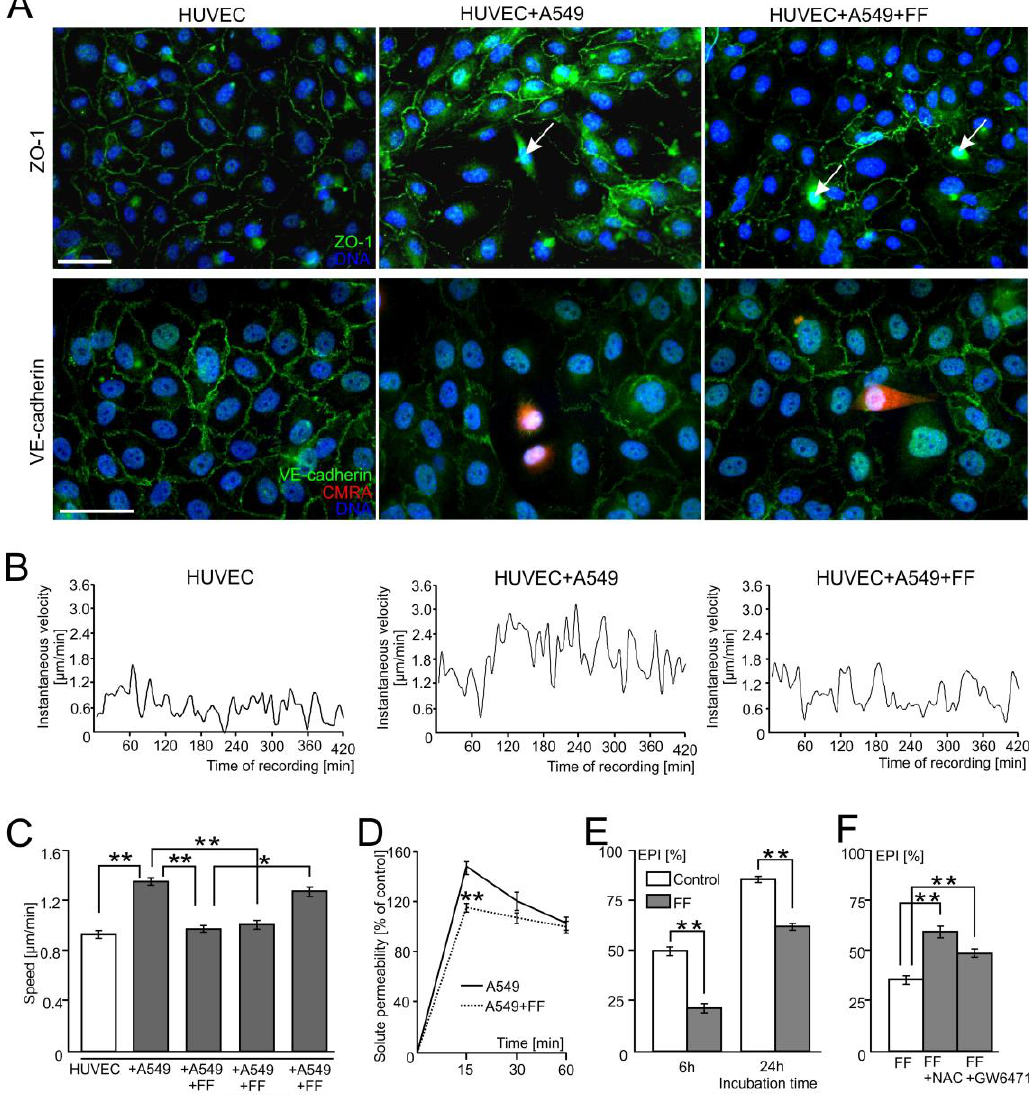
Figure 1. Fenofibrate inhibits the penetration of the endothelial layer by lung adenocarcinoma (A549) cells. Human lung cancer A549 cells (stained with CMRA-Cell Tracker or marked with arrows) were seeded onto human umbilical vein endothelial cell (HUVEC) monolayers at the density of 1300 cells/cm 2 . The integrity of endothelial continua, HUVEC motility, and endothelial permeability was assessed by anti-ZO-1/VE-cadherin immunostaining (( A ); 6 h), time-lapse videomicroscopy (( B , C ); 7 h), and solute permeability tests ( D ), respectively, in the absence or in the presence of 25 µ M fenofibrate (FF). ( B , C ) shows instantaneous speeds of single HUVEC in control conditions and in the presence of A549/25 µ M FF, and the comparison of average speeds of HUVEC movement in the presence of A549 cells/FF/GW6471/NAC, respectively, quantified based on changes in cell centroid position. ( E ) The effect of FF on the efficiency of A549 diapedesis (TransEndothelial Penetration; EPI) was estimated after 6 and 24 h of co-culture. ( F ) Effect of PPAR α inhibitor (GW6471) and ROS scavenger (N-acetyl-L-cysteine; NAC) on A549 diapedesis (EPI), estimated after 6 h of A549/HUVEC co-culture. Transmigration of at least 200 A549 cells was analyzed for each group. The statistical significance of the differences in ( C – F ) was tested with one-way ANOVA followed by a post-hoc Tukey’s HSD comparison (* p < 0.05 and ** p < 0.01). Error bars represent SEM. All results are representative of at least three independent experiments ( n ≥ 3). Scale bar = 40 µ m. Note that the relatively efficient diapedesis of A549 cells is considerably inhibited by